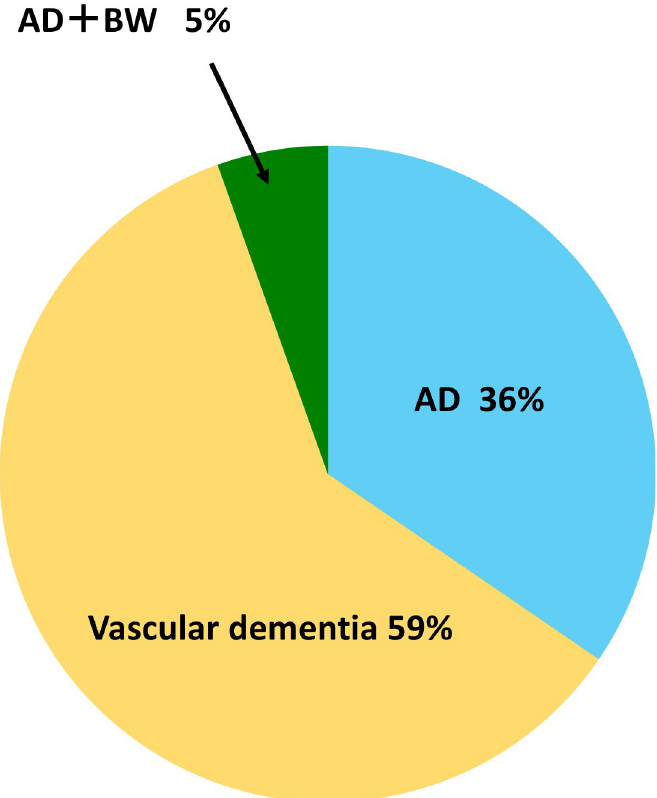
Fig 2. Differential diagnosis of 56 hip fracture patients diagnosed as having dementia. AD: 20 (36%), vascular dementia: 33 (59%), AD + BW: 3 (5%). Vascular dementia as well as AD is commonly seen in HipFx patients. AD: Alzheimer’s disease, BW: Binswanger’s